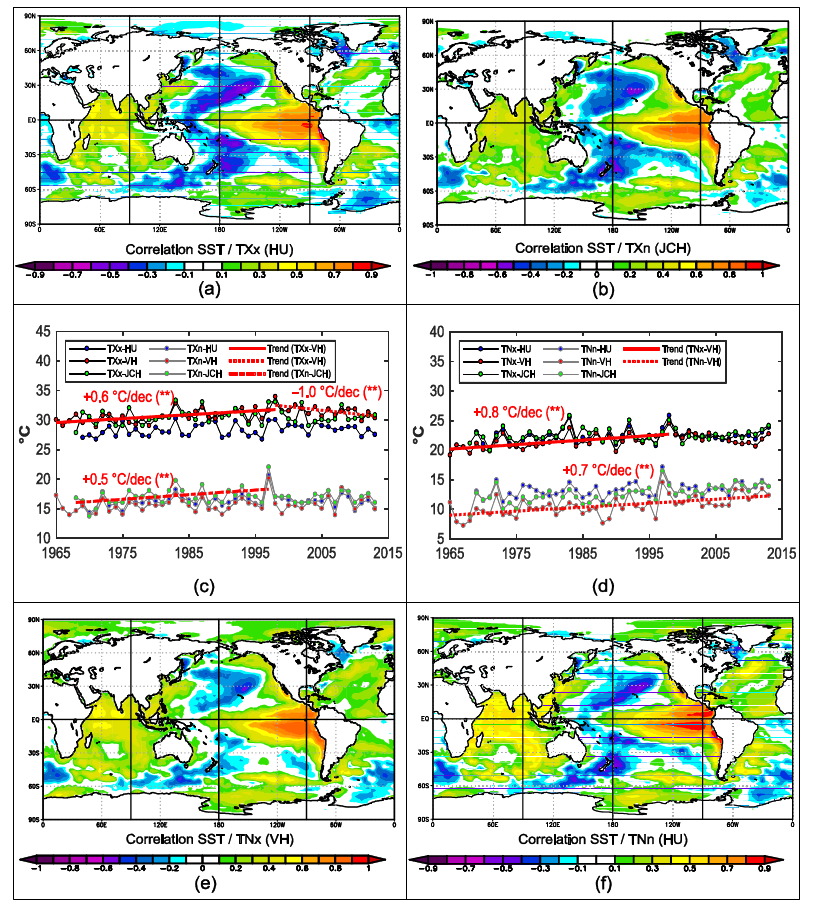
Figure 8. Spatial field of annual correlations between Sea Surface Temperature (SST) and ( a ) TXx, ( b ) TXn, ( e ) TNx, and ( f ) TNn for the period 1965 – 2013. Variability and trends of extreme tempera-